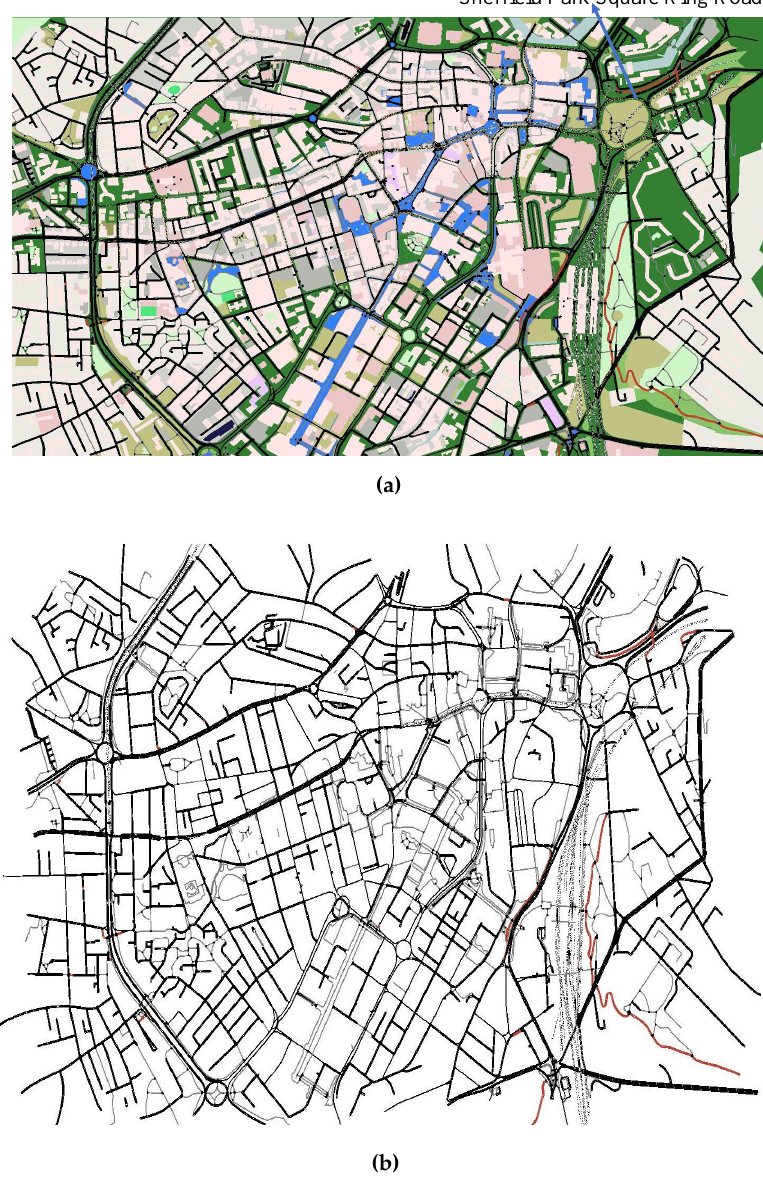
Figure 5. The city centre of Sheffield and the SUMO map. ( a ) The city centre of Sheffield; ( b ) SUMO map of Sheffield city